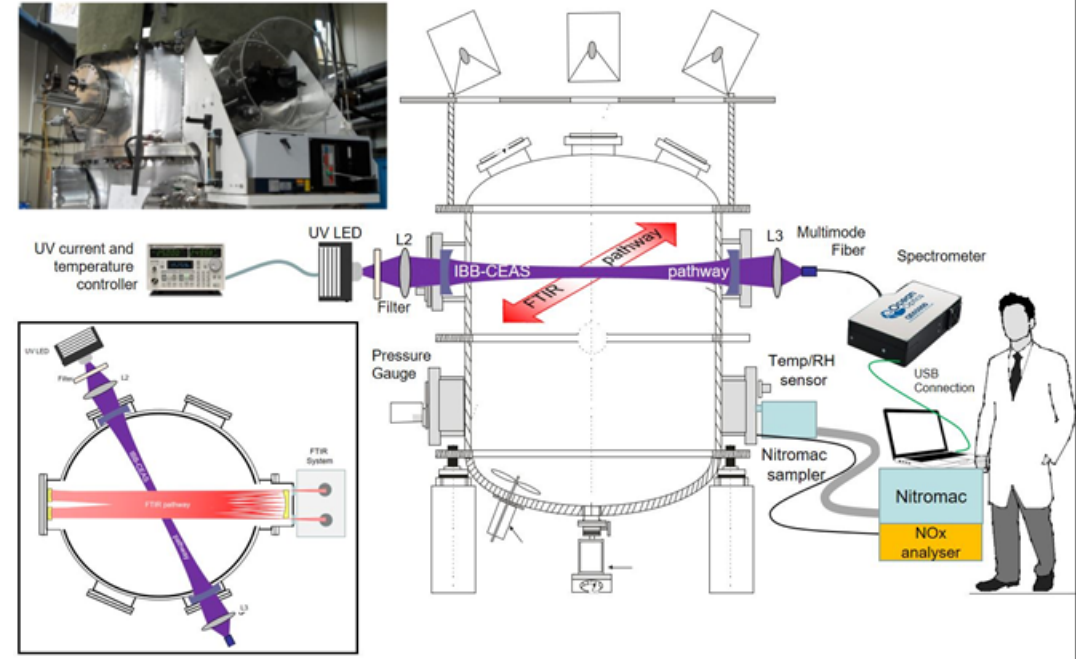
Figure 1. Schematics of the experimental set-ups and devices installed around the CESAM chamber for intercomparison: IBBCEAS, Nitro- MAC, FTIR spectrometer, NO x analyser, temperature and relative humidity sensor ( T & RH sensor), and pressure gauge. An insert displays a photograph of the set-up (top left) and a schematic view from the top showing the angle between the two in situ spectrometric path- ways (bottom left). L2 and L3 are BK7 achromatic focus lens. Cavity mirrors had 25mm in diameter, 2m radius of curvature and 6.35mm thickness.